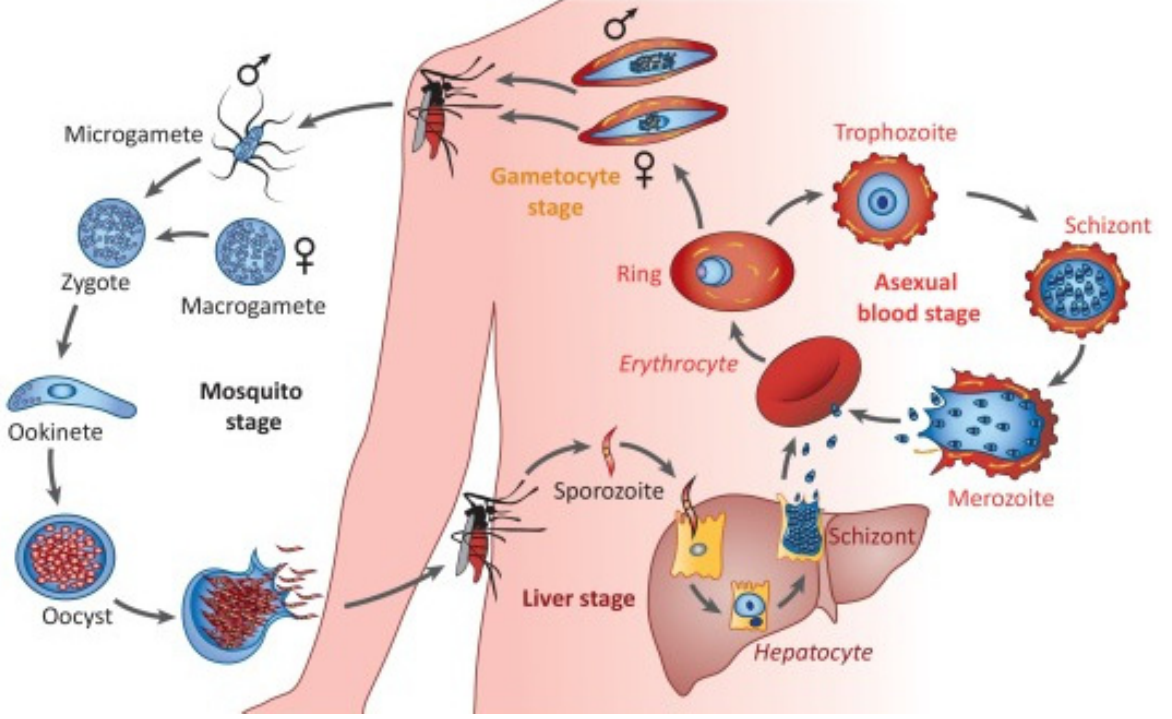
Figure 1. The life cycle of Plasmodium falciparum . Reproduced with permission from [4], Cell Press, 2018. Malaria is classified by the World Health Organization (WHO) as a life-threatening disease that, despite being preventable and treatable, is still endemic in 87 countries, mainly in the tropical and subtropical regions [1]. The last WHO report on malaria estimated that in 2020, there were 241 million cases and 627,000 deaths worldwide, with the WHO African Region accounting for 95% of them [7]. Despite the decrease in disease burden and deaths experienced over the past years, the goal of malaria elimination is still far, mainly because of a lack of continued financing and the emergence of parasite resistance to the antimalarial drugs administered [1]. To achieve the global objective of malaria eradication, there is a need for research on the development of novel and affordable strategies for prevention and treatment, among which nanomedicine can play a pivotal role